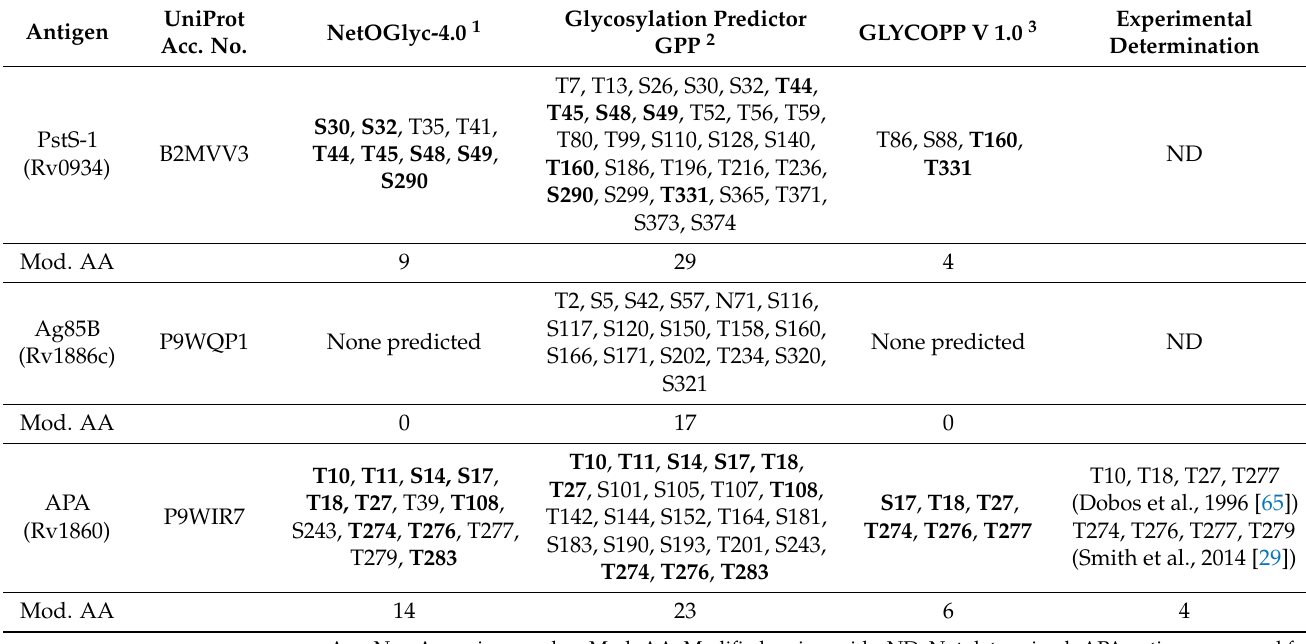
Table 1. Potential glycosylated residues in recombinant antigens PstS-1 and